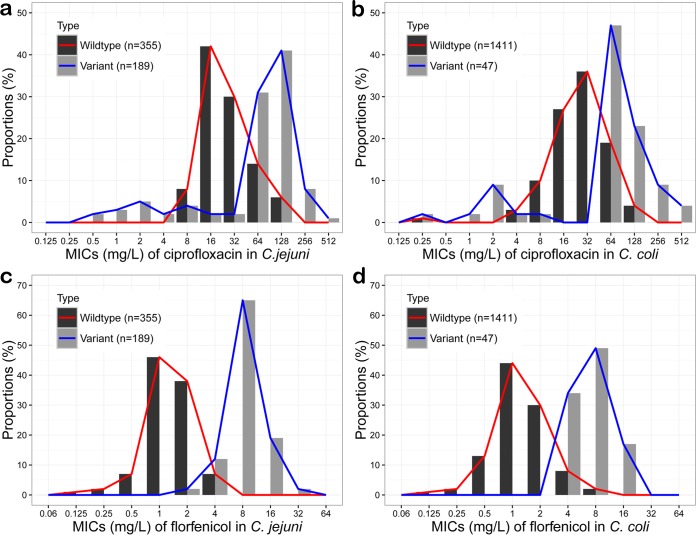
Distribution of ciprofloxacin and florfenicol MICs for Campylobacter isolates with RE-cmeABC or other CmeABC types. (a) Distribution of ciprofloxacin MICs for C. jejuni. (b) Distribution of ciprofloxacin MICs for C. coli. (c) Distribution of florfenicol MICs for C. jejuni. (d) Distribution of florfenicol MICs for C. coli. In all panels, “Variant” indicates strains that contain RE-cmeABC while “Wildtype” depicts isolates containing a cmeABC operon that is not RE-cmeABC.